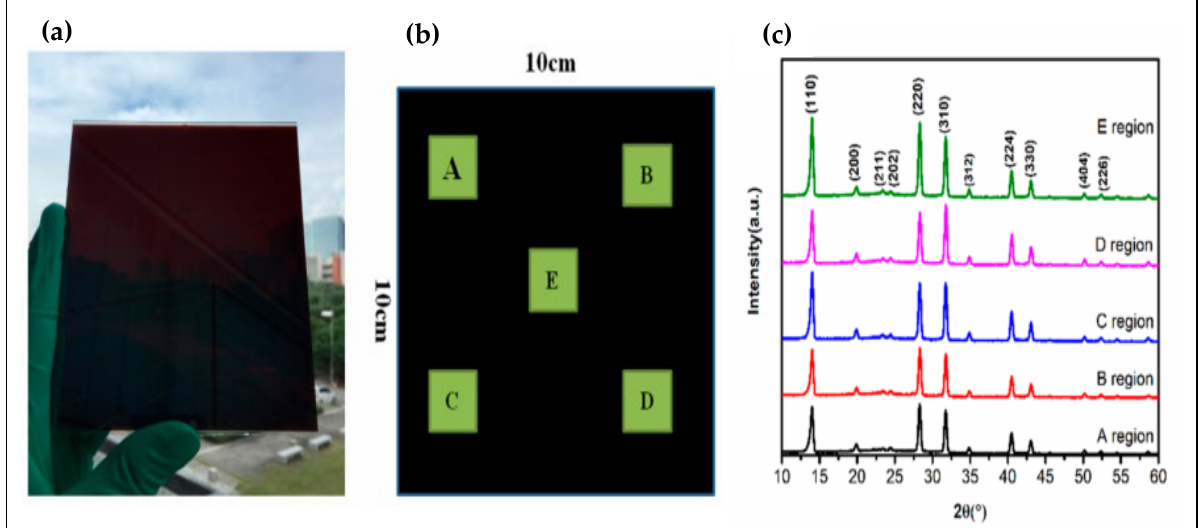
Figure 12. Low resolution images ( a , b ) of the 100 cm 2 PSC prepared by the thermal-vapor-deposited method. ( c ) XRD patterns at the marked regions A, B, C, D, and E [75].